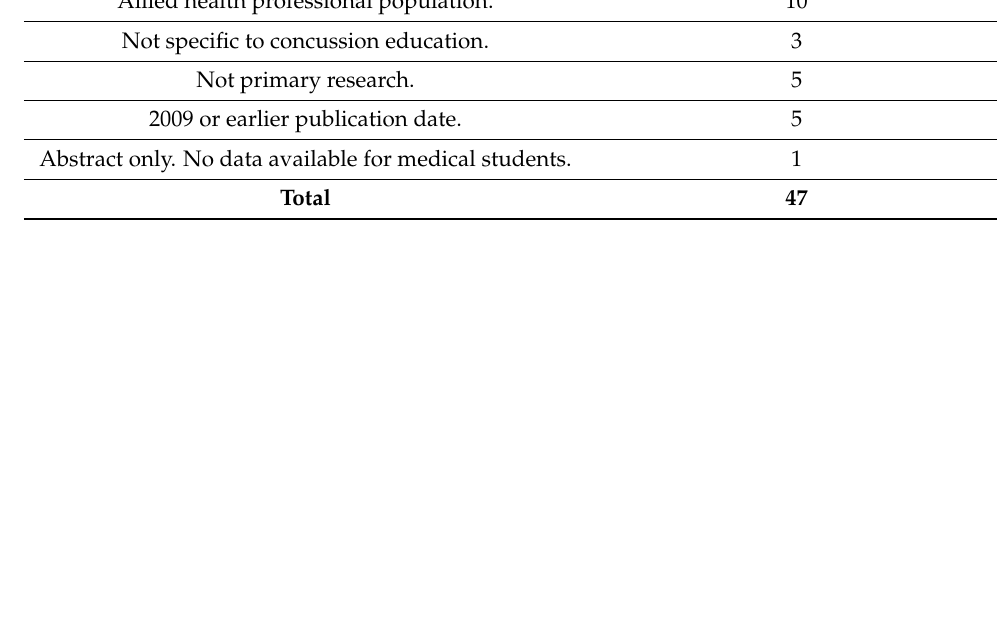
Table 1. Papers excluded at abstract stage. Postgraduate population. 23 Allied health professional population. Not specific to concussion education. Not primary